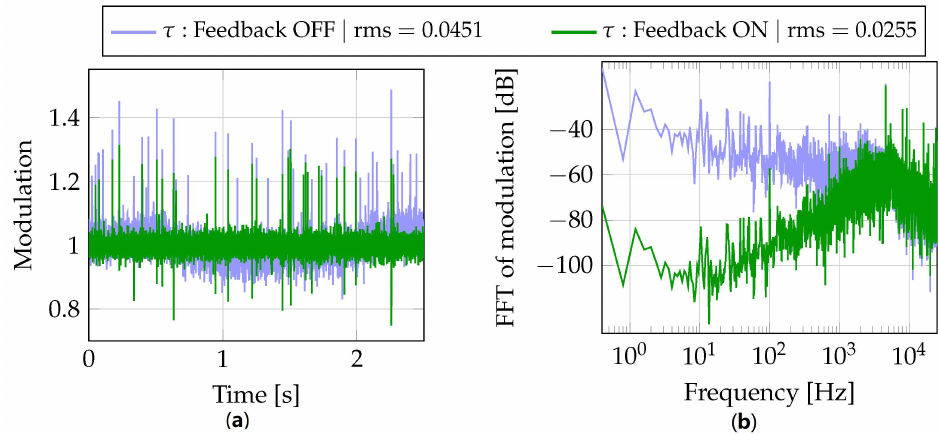
Figure 6. Simulation of BBF regulator with BAM readout in ( a ) time and ( b ) frequency